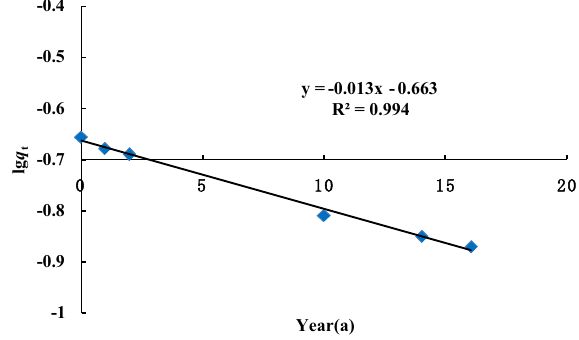
y = -0.013x -0.663 R² = 0.994